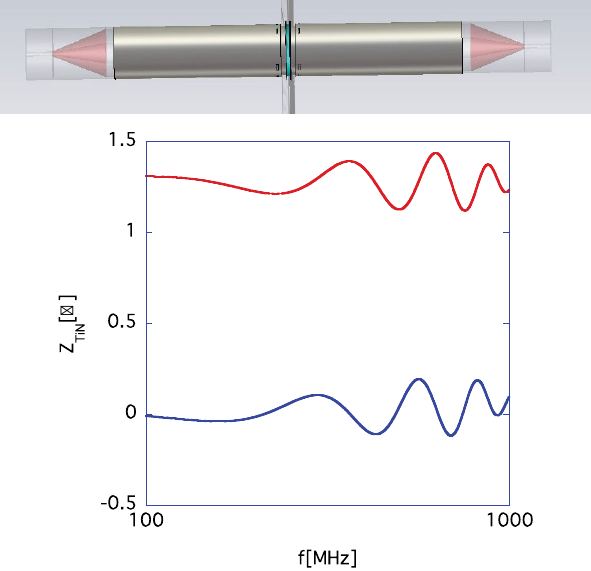
FIG. 9. Simulations (lower) of the longitudinal impedance with both tapers in the setup shown in the upper figure. The horizontal axis is frequency in logarithmic scale.